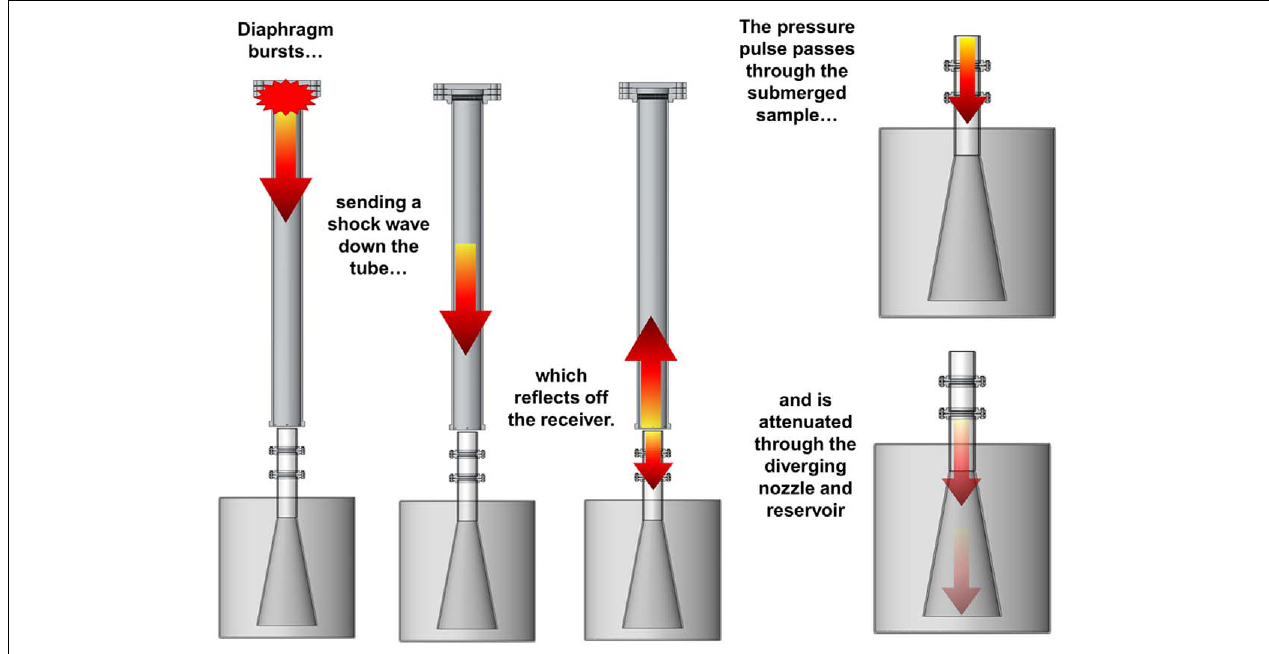
FIGURE 3 | Illustration of the blast system during a test. A blast wave generated in the shock tube impacts the top surface of the receiver, sending a pressure pulse down the fluid within the test column that passes through the in vitro sample and attenuates into the